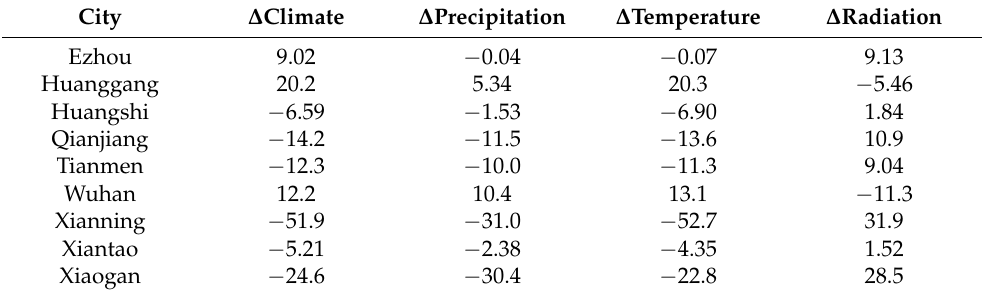
Table 5. The effects of climate change, precipitation, temperature and radiation on total carbon sequestration (10 10 gC) for the Wuhan City Circle area between 2000 and 2015. ∆ Climate, the effect of climate changes; ∆ Precipitation, the effect of precipitation changes; ∆ Temperature, the effect of temperature changes; ∆ Radiation, the effect of radiation changes. City ∆ Climate ∆